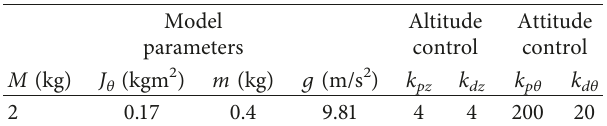
Table 1: Parameters of the model and altitude, and attitude